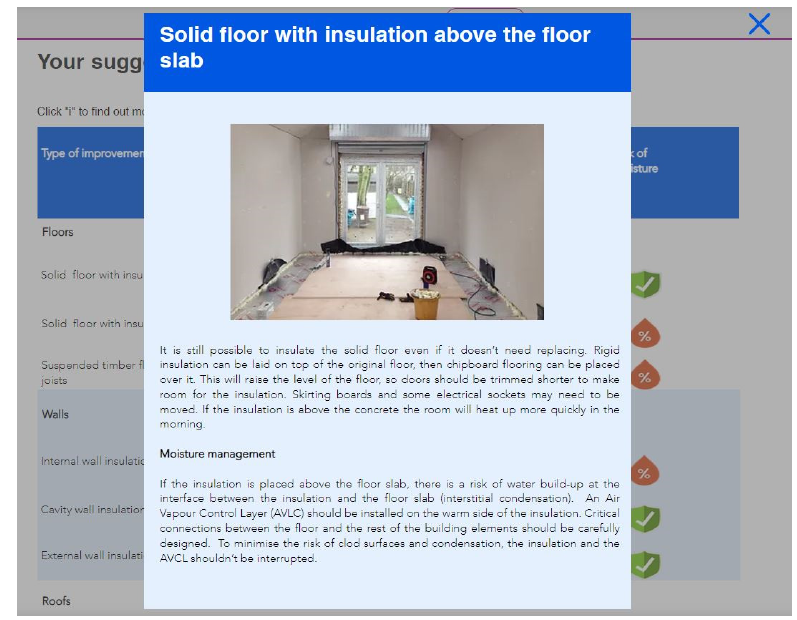
Figure 8. “i” icon to learn more about moisture risks related to each solution.